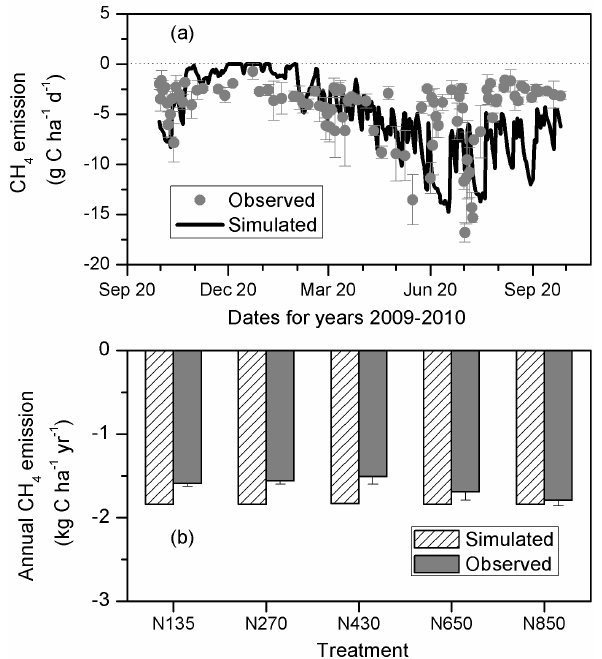
Fig. 5. Observed and simulated daily methane (CH 4 ) fluxes for treatment N430 (a) , and cumulative CH 4 emissions (b) for treat- ments N135, N270, N430, N650 and N850 from 2009 to 2010. Treatment code definitions can be found in Table 1 and in the text. The observed data were adapted from Liu et al.